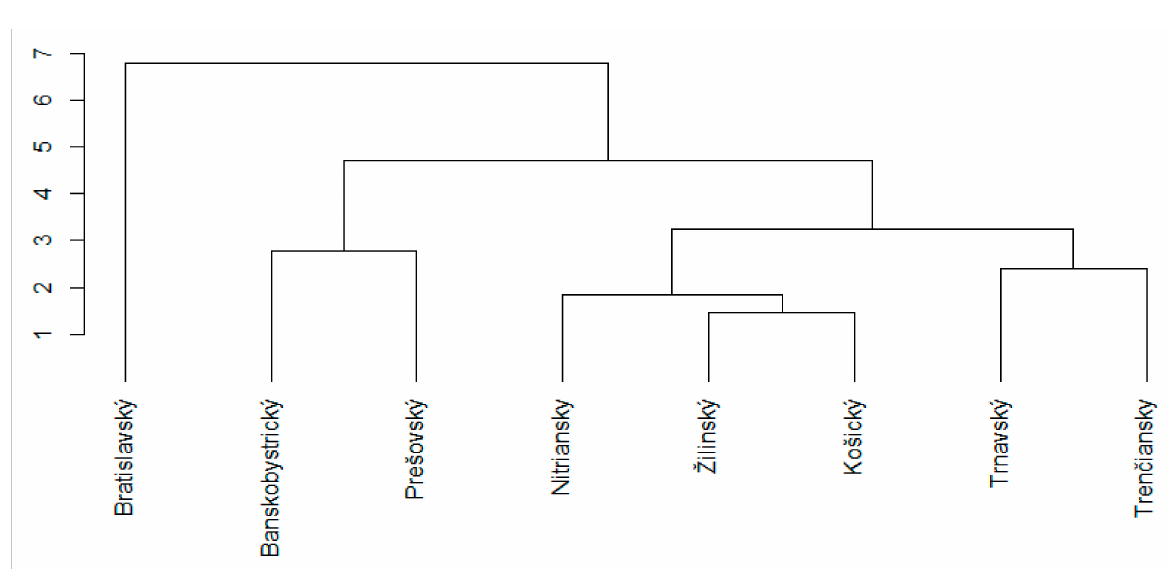
Figure 12. Cluster dendogram in